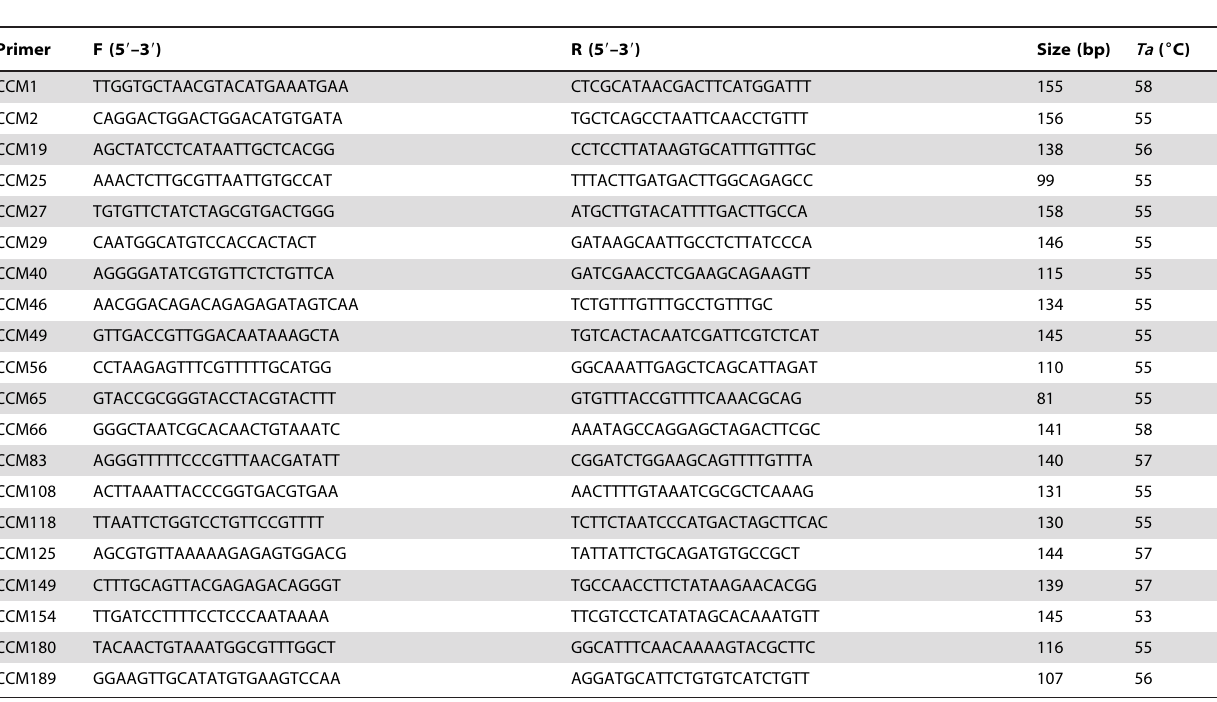
Table 7. Characteristics of 20 polymorphic SSR markers used in genetic diversity analysis (F=forward primer, R=reverse primer, Size= size of cloned allele, Ta=annealing